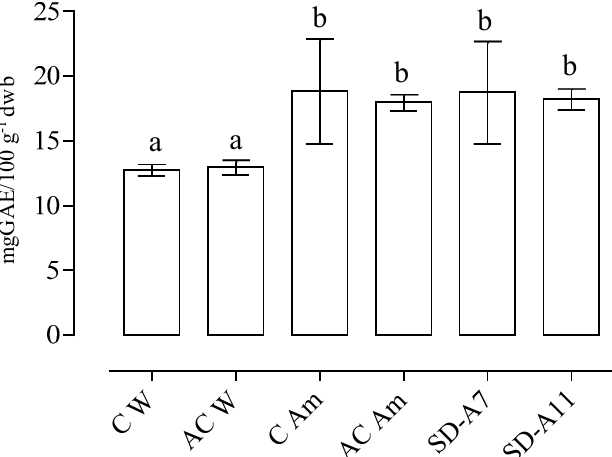
Figure 2. Total phenolic content (expressed as mg of gallic acid equivalents GAE100 g − 1 dwb) of the breads (data are expressed as mean ± coe ffi cient of variation %). C W—wheat control bread; AC W—wheat acid control bread; C Am—amaranth control bread; AC Am—amaranth acid control bread; SD-A7— L. brevis A7 bread; SD-A11— L. farciminis A11 bread. Di ff erent letters ( a − b ) indicate signi fi cant